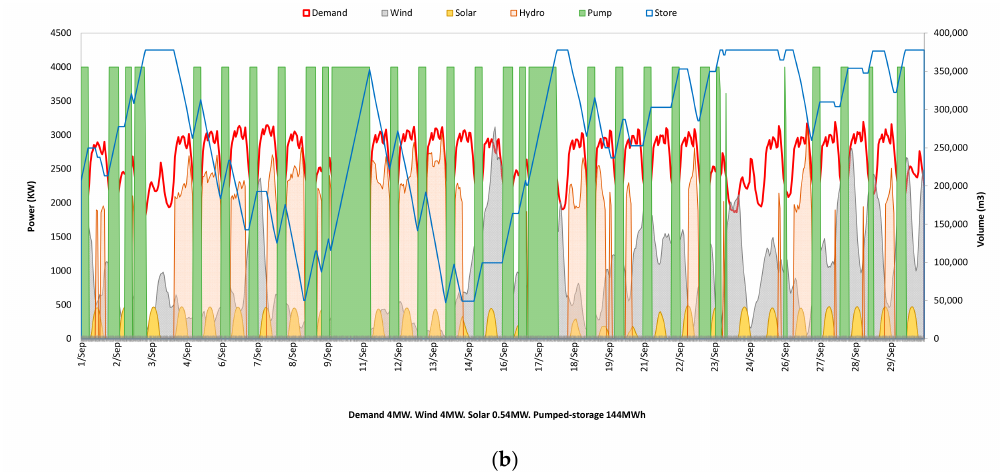
Figure 8. Electricity generation (Wind, PV and Pumped-Storage Hydro) between August ( a ) and September ( b ).